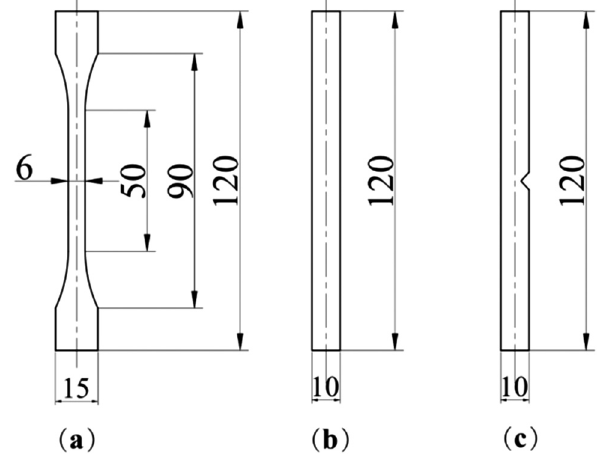
Figure 5: Standard samples size for ( a ) tensile, ( b ) bending, and ( c ) impact